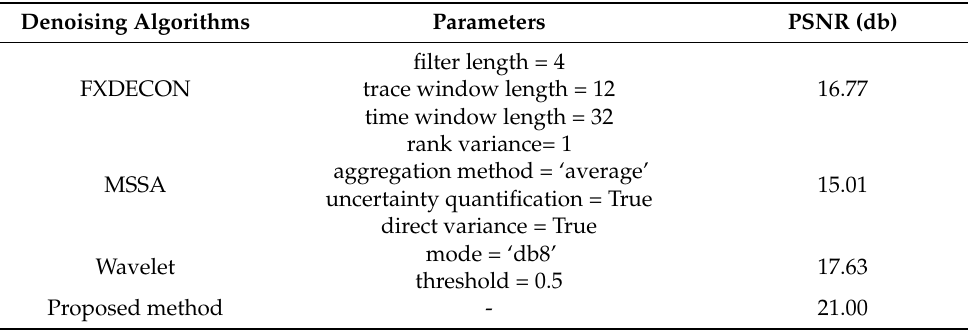
Table 5. Quantitative evaluation of FXDECON, MSSA, wavelet transform, and the proposed methods. Parameters are tuned manually.